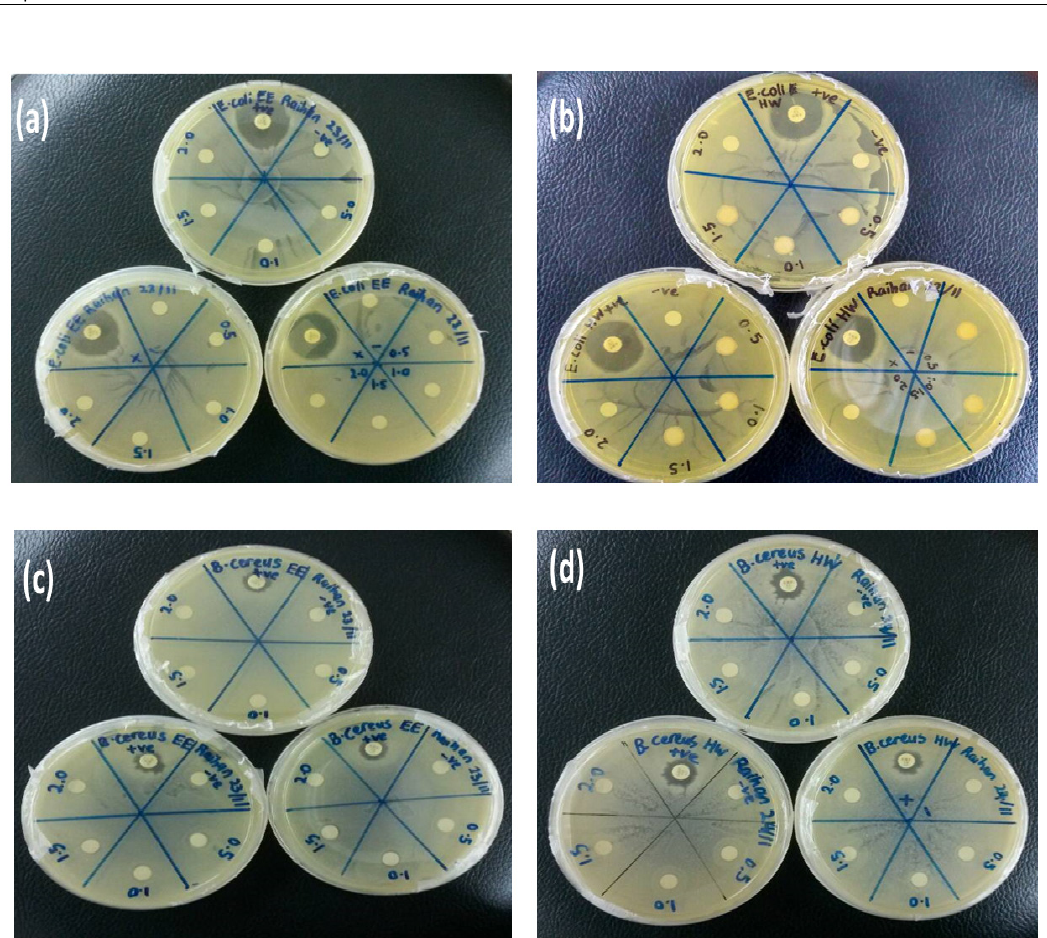
Fig. 3: Antimicrobial activity assay (a); Inhibition zone of E. coli (b); Inhibition zone of B. cereus (c)